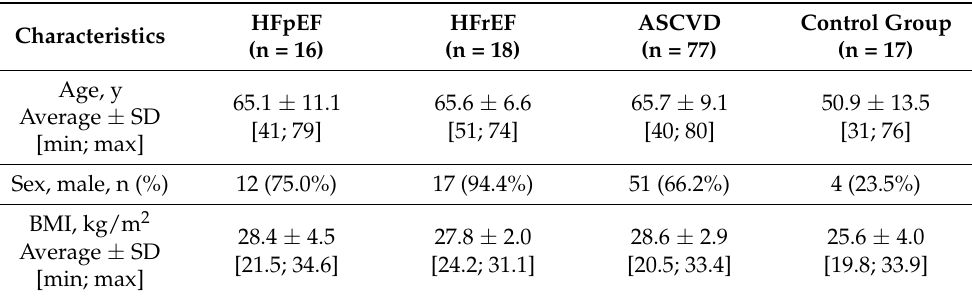
Table 3. Baseline characteristics of patients for NGS analysis.